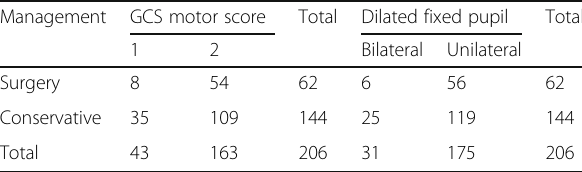
Table 4 The type of management according to the GCS motor score and the pupillary